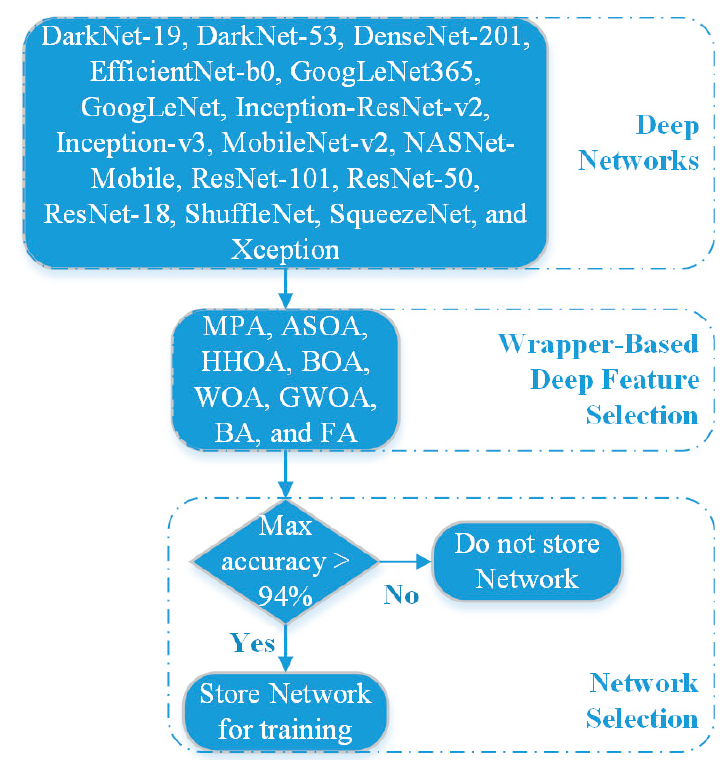
Figure 4. Network selection framework.